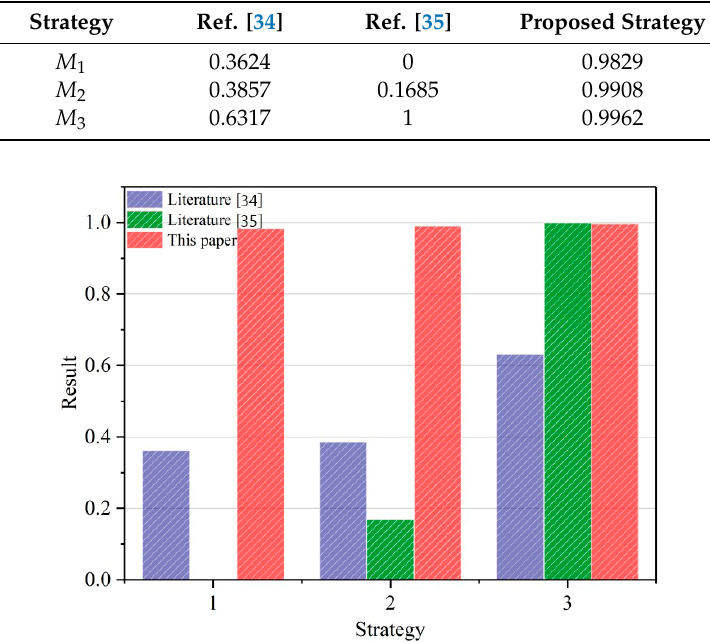
Figure 4. Comparison of the evaluation results.